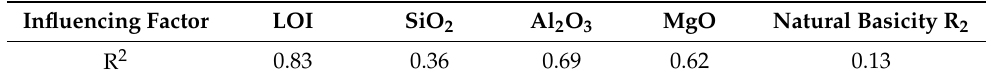
Table 6. Fitting degree of each influencing factor.